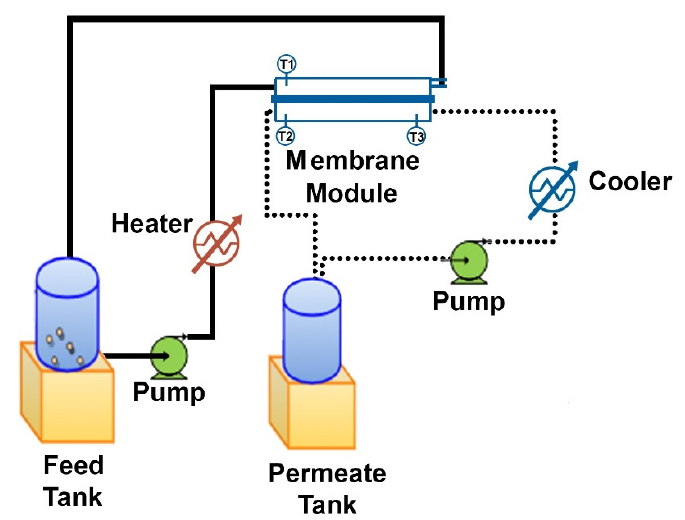
Figure 1. Process scheme of the DCMD setup.